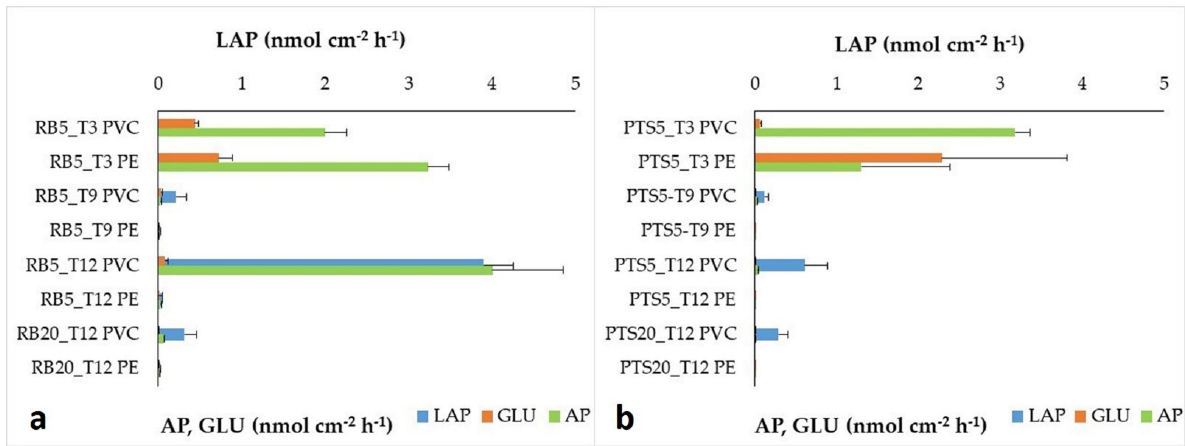
Figure 5. Mean values + standard deviations of enzymatic activity rates (Leucine aminopeptidase, LAP; beta-glucosidase, GLU; alkaline phosphatase, AP) measured in the microbial biofilm developed on plastic materials submerged in the Road Bay area at 5 m and 20 m for 3, 9 and 12 months (T3, T9 and T12, respectively). ( a ), RB, Road Bay (impact station); ( b ), PTS, Punta Stocchino (control station). PVC: Polyvinyl chloride; PE: Polyethylene.